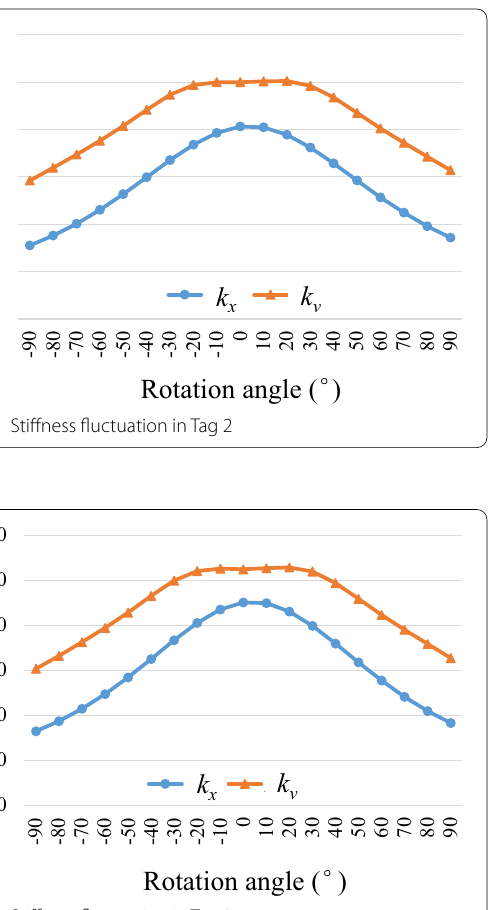
Figure 21 Stiffness fluctuation in Tag 3